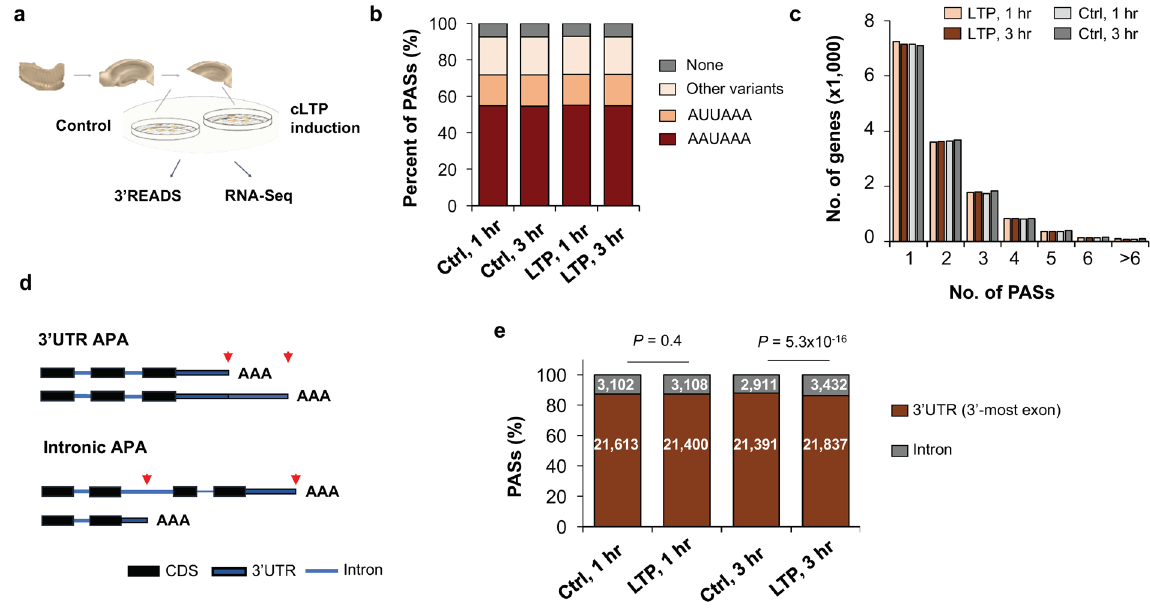
Figure 1. Analysis of APA in LTP. ( a ) Experimental design. RNAs from chemical LTP (cLTP)-induced and time-matched control hippocampal slices were subjected to 3 ′ READS + analysis to examine APA, or RNA-seq for gene expression. ( b ) Distribution of the A[A/U]UAA element in identified poly(A) sites (PASs). Percentage of PASs associated with either AAUAAA, AUUAAA, other variants of A[A/U]UAAA, or not associated with any A[A/U]UAAA element are shown for each sample group. ( c ) Number of PASs identified per gene. Genes with only one PAS have the highest frequency and the majority of genes displayed APA in the hippocampal samples analyzed. ( d ) Diagram showing 3 ′ UTR APA (top) and intronic APA (bottom). 3 ′ UTR APA isoforms have alternative 3 ′ UTRs resulting from the choice of different PASs in the 3 ′ UTR. Two PASs are shown, i.e., proximal PAS and distal PAS. Intronic APA isoforms have different 3 ′ UTRs as well as coding sequences (CDS). ( e ) Distribution of PASs in different regions of the mRNA: 3 ′ UTR (in 3 ′ -most exon only) vs. upstream intron. Change of PAS distribution during LTP is observed 3 hr post LTP induction. Number of PAS in each region is specified in each bar. P-values (Binomial test) indicate difference in fractions of 3 ′ UTR PASs and intronic PASs in LTP vs. control